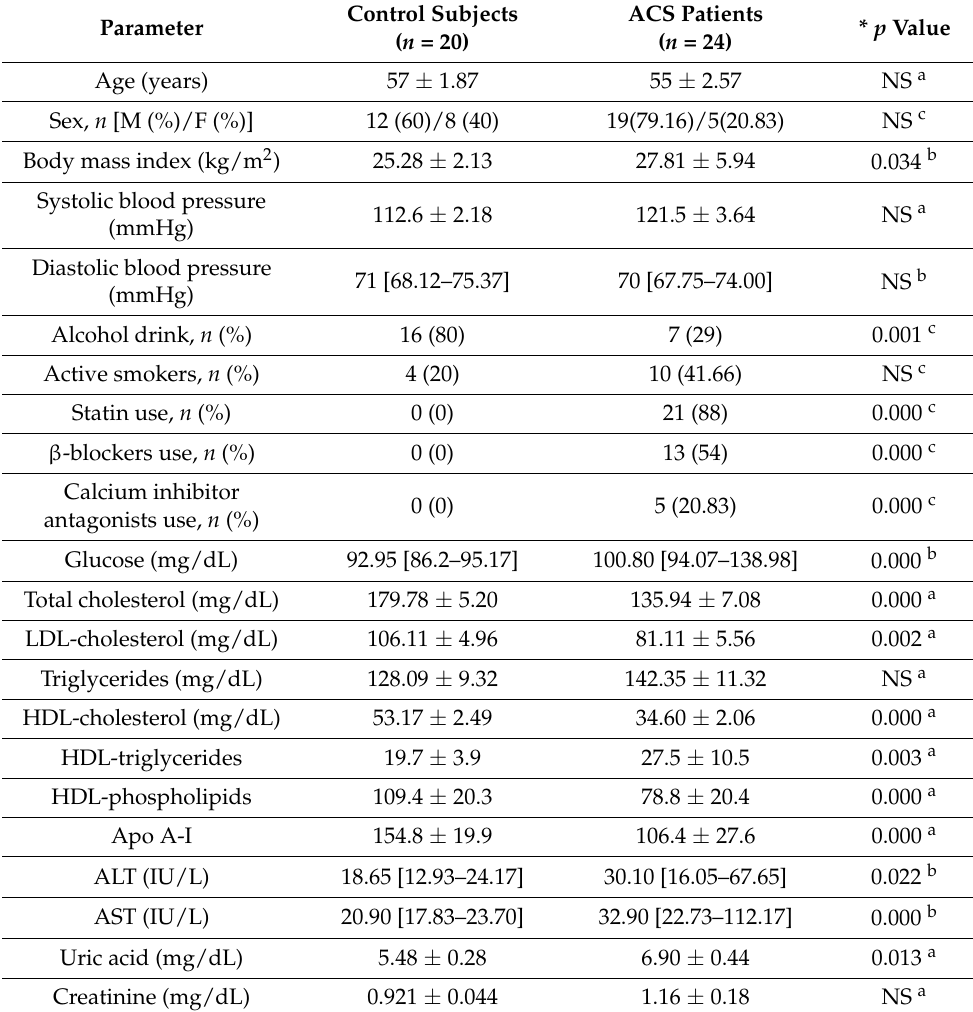
Table 1. Anthropometric characteristics, biochemical data, and pharmacological treatment of the included